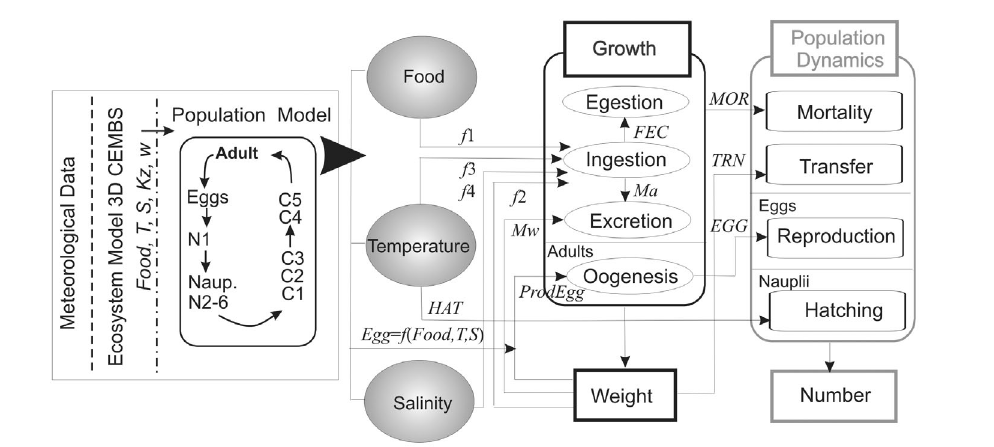
Fig. 2. Conceptual diagram of the population model combined with the 3D CEMBS model (3D Coupled Ecosystem Model of the Baltic Sea). See text for the explanation of the abbreviations.